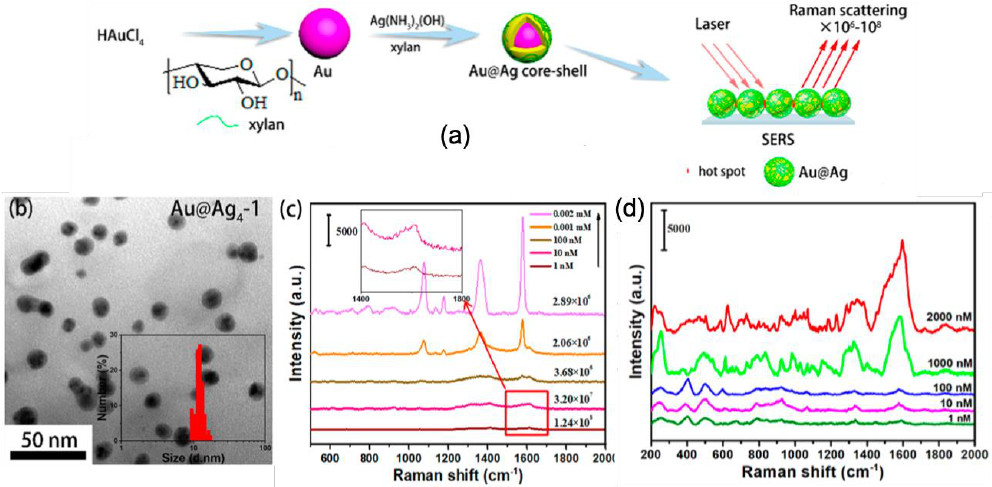
4. Figure 3. ( a ) Principle scheme of the synthesis of Au/Ag core-shell nanoparticles by using xylan for SERS sensing. ( b ) TEM image of xylan-capped Au@Ag nanoparticles with optimized parameters for SERS. SERS spectra of ( c ) 4-MBA molecules and ( d ) Sudan I molecules for different concentrations obtained with optimized xylan-capped Au/Ag nanoparticles of ( b ). All the figures are reprinted (adapted) with permission from [84], Copyright 2019 American Chemical Society.